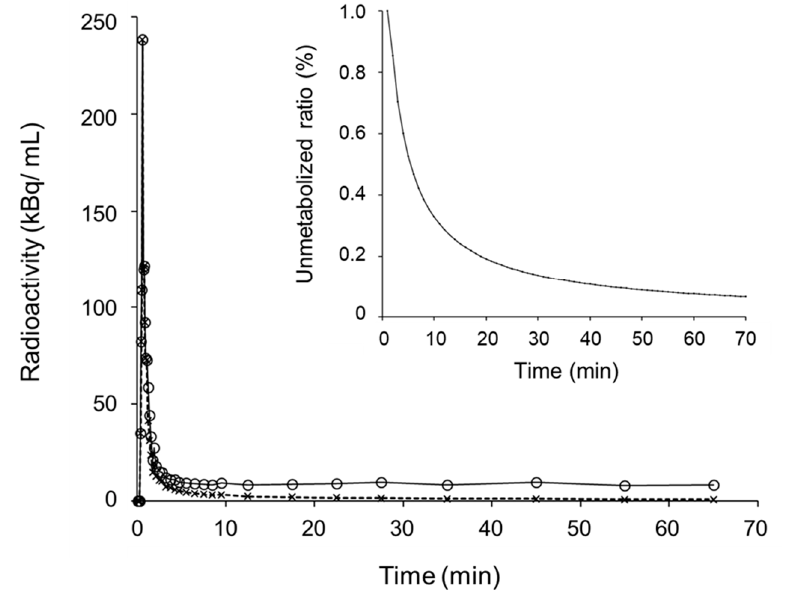
Figure 1. Representative time–activity curves (TAC) of the arterial blood ( ○ ) obtained from the image-derived input function (IDIF) method and metabolite-corrected plasma input ( × ) in a healthy control. Insert shows an arterial unmetabolized [ 11 C]PiB ratio curve defined by a Hill-type function. Representative TACs of the cerebral (solid line) and cerebellar (dashed line) cortices from each